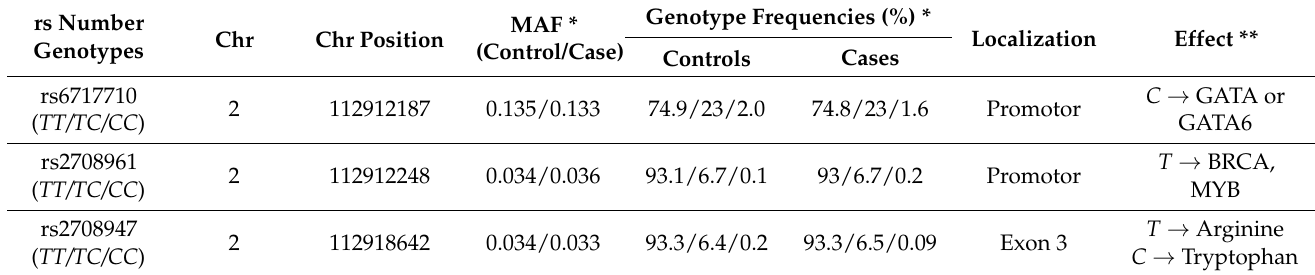
Table 2. Characteristics of IL-37 polymorphisms in the present study.